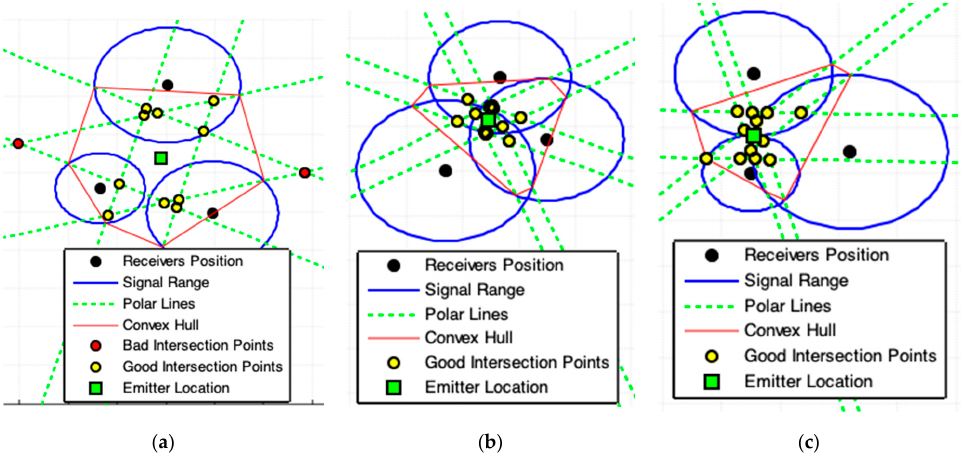
Figure 8. Results produced by Polar Lines Intersections Model (PLI). ( a ) and ( b ) show the possible presence of noise in acquired data. ( c ) Represents the best case for acquired data. For this case is better applying the exact solution provided by Section